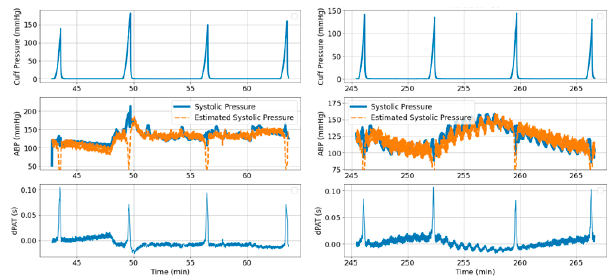
Figure 14. Example of PAT-based BP estimation in Patient 1 .